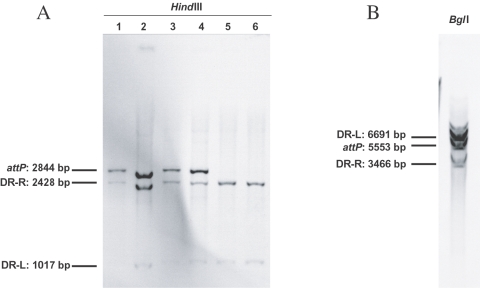
Chromosomal junctions of tandemly-arranged SGI1 islands in the S. Typhimurium LT2 chromosome.(A) Southern blot hybridization with the 364-bp attP SGI1 probe containing part of S044, 18 bp attP site and part of the int gene of HindIII-digested genomic DNAs of wild type S. Typhimurium LT2 SGI1 transconjugants. Lanes 1-4 correspond to different transconjugants with tandem arrays of SGI1 integrated at the 3′ end of thdF and lanes 5-6 to transconjugants with a single SGI1 integrated at this attB site. (B) Southern blot hybridization with the 364-bp attP SGI1 probe of BglI-digested genomic DNA of ΔthdF mutant S. Typhimurium LT2 SGI1 transconjugants. All transconjugants tested showed the same profile with BglI fragments containing DR-L, DR-R, and attP. The molecular sizes of HindIII or BglI fragments containing DR-L, DR-R, and attP are indicated.